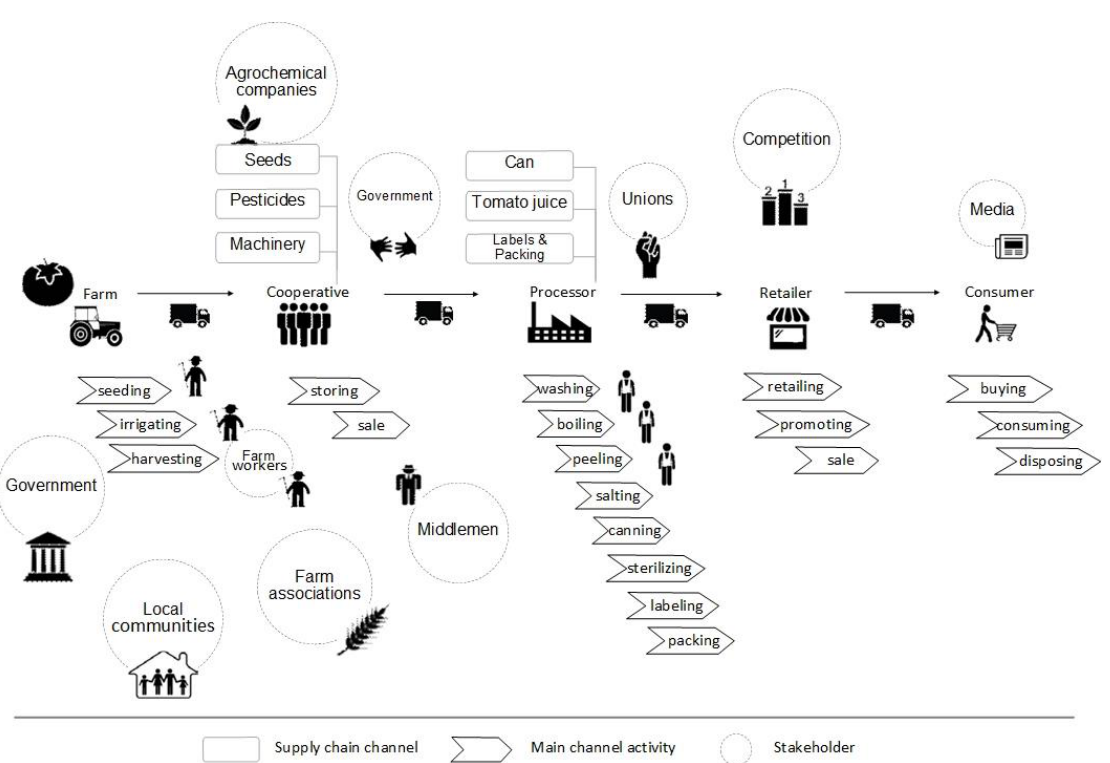
Figure 3. Tomato Value Chain.